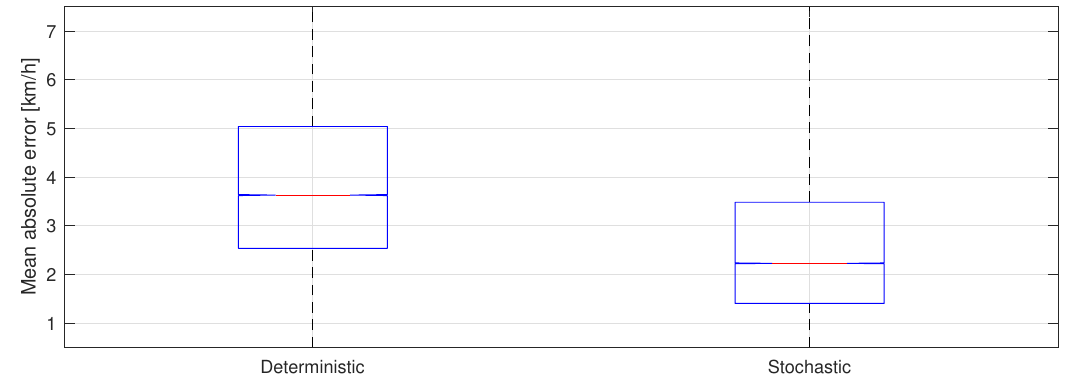
Figure 7. Constructed speed trajectory error comparison between deterministic and stochastic approach for stop